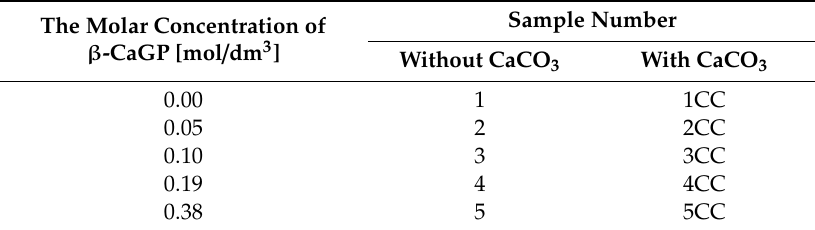
Table 1. The composition of the solutions used in the studies with their designations. The Molar Concentration of β -CaGP [mol / dm 3 ]